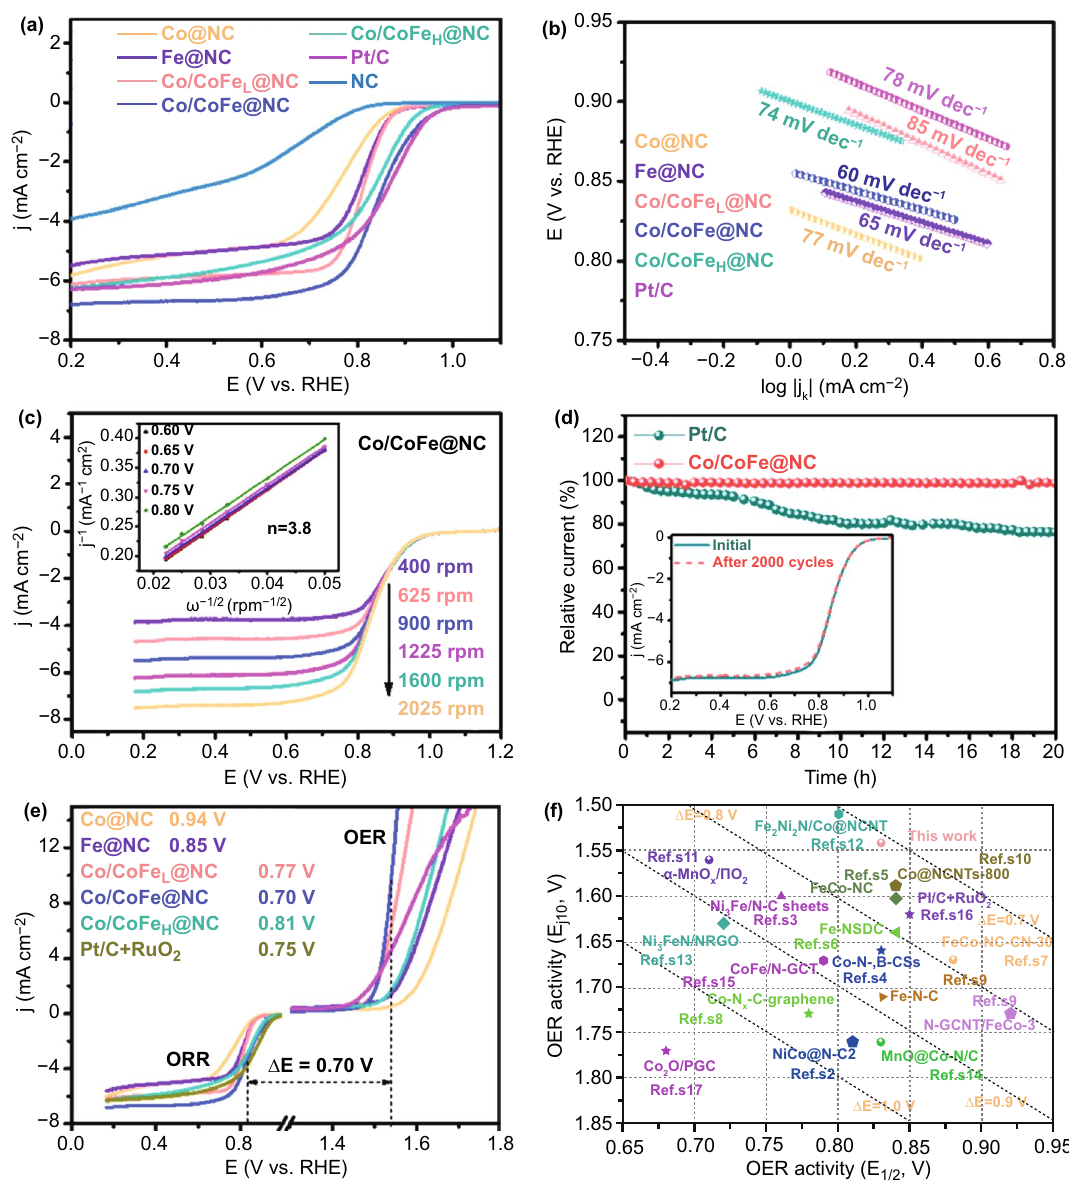
Fig. 5 a ORR polarization curves and b corresponding Tafel slopes of the as‑prepared catalysts and Pt/C in 0.1 M KOH. c RDE polarization profiles of Co/CoFe@NC at various rotation speeds and the inset of c shows the respective K‑L plots for different voltages. d Chronoamperomet‑ ric response of the Co/CoFe@NC and Pt/C at a constant potential of 0.6 V; the inset of d shows LSV curves of Co/CoFe@NC before and after chronoamperometric measurements. e Overall polarization curves of all samples over entire ORR and OER region. f Comparison of the bifunc‑ tional ORR ( E 1/2 ) and OER ( E j =10 ) activities in this work with representative electrocatalysts reported recently (the dotted lines denote the ∆ E at constant